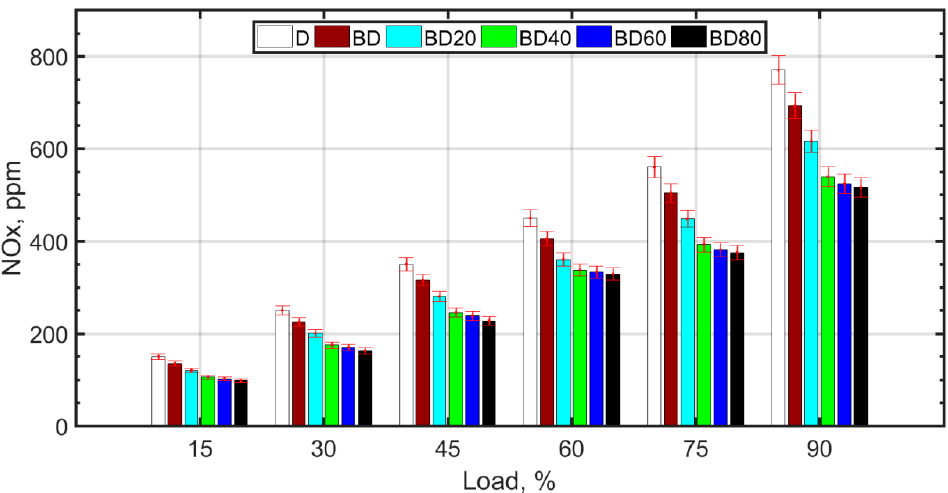
Figure 5. NOx variation with load.